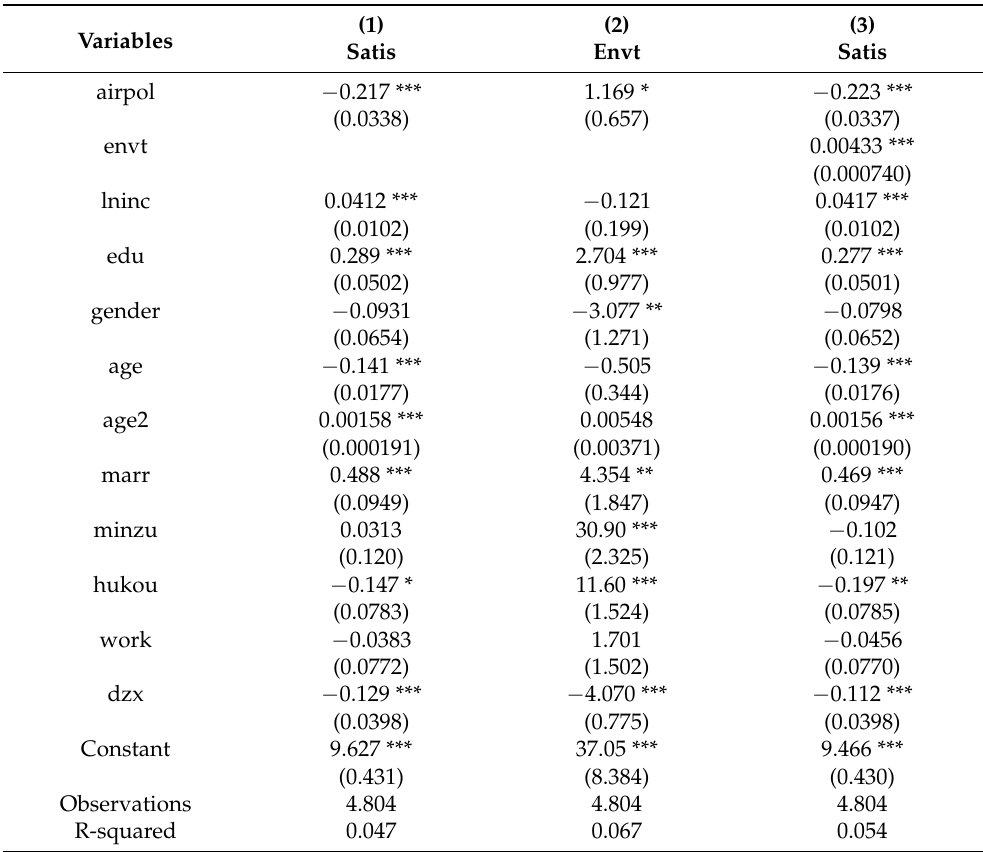
Table 8. Robustness test.